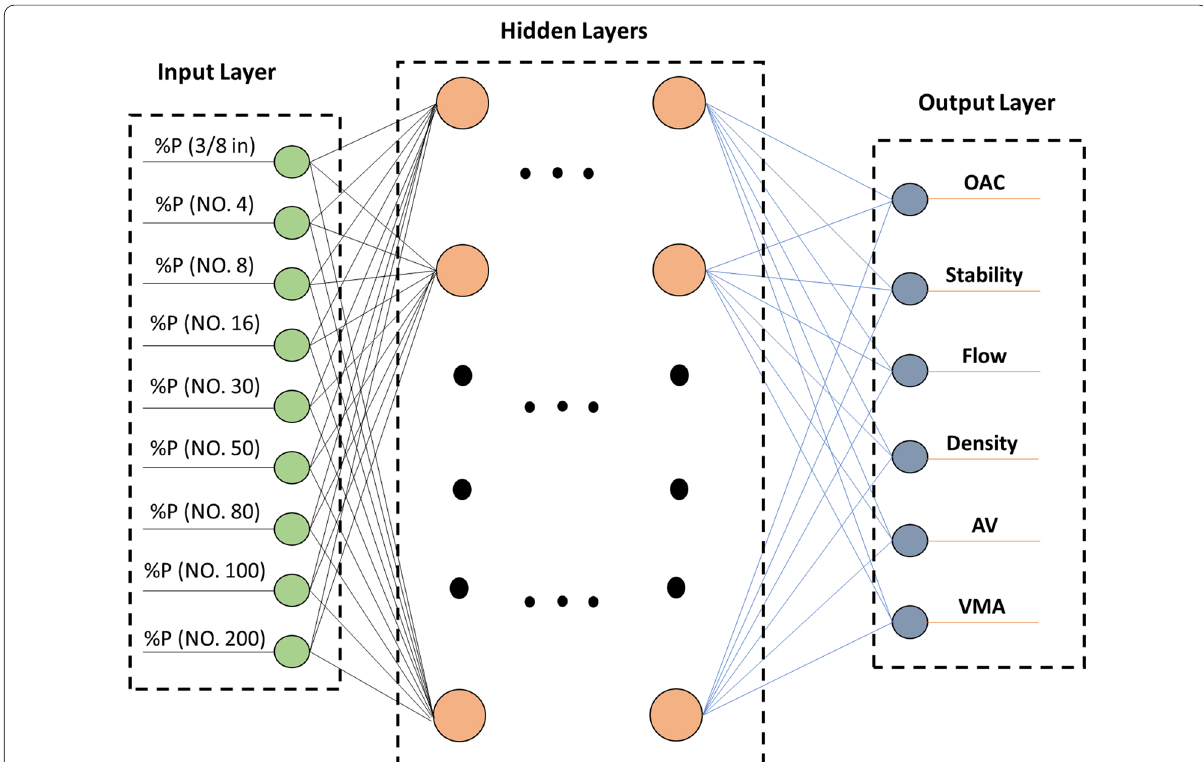
Fig. 4 General architecture of the proposed